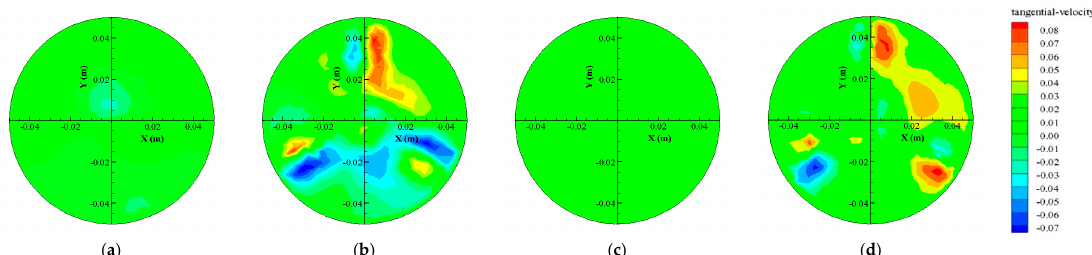
Figure 8. Circumferential velocity distributions of the downstream sections of capsules. ( a ) Z = 0.225 m, L / D = 2; ( b ) Z = 0.075 m, L / D = 2; ( c ) Z = 0.225 m, L / D = 1.67; ( d ) Z = 0.075 m, L / D = 1.67.